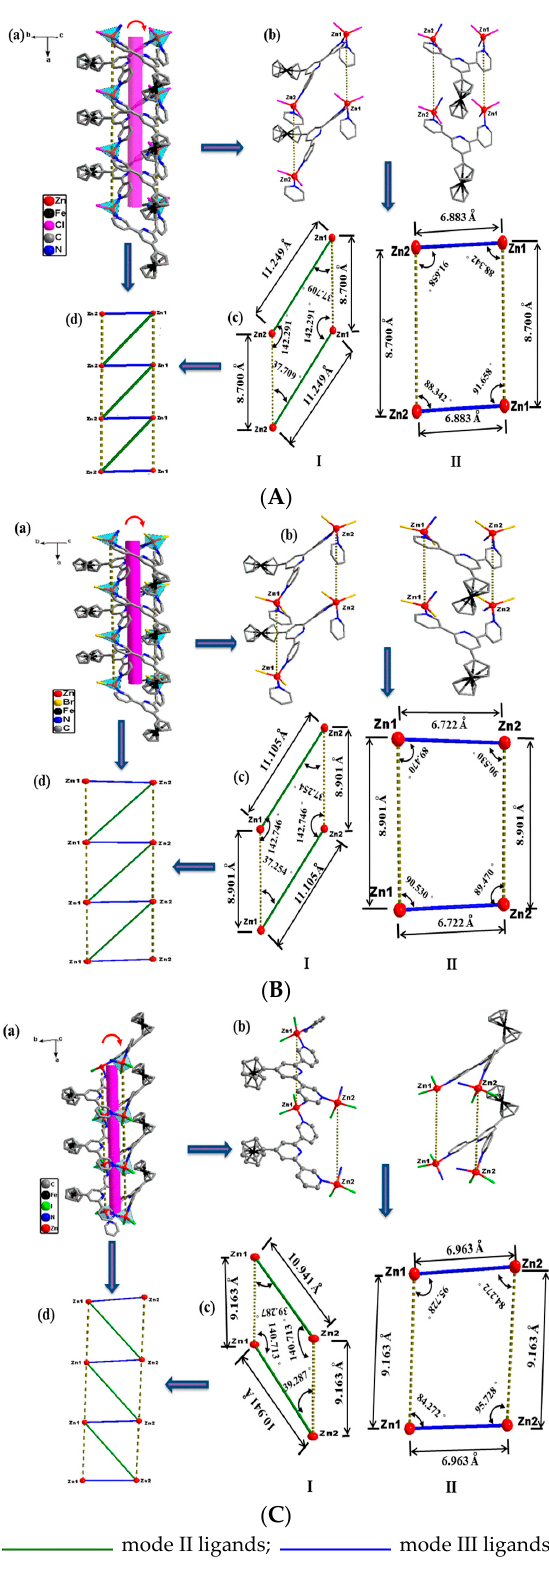
Figure 5. (a) The 1D double-stranded metal ion left-handed helical polymer chains of complexes 1 ( A ), 2 ( B ) and 3 ( C ) (H atoms and solvent molecules are omitted for clarity); (b) two connecting formations connected by different coordination mode ligands; (c) two types of parallelogram-like skeletons; (d) the ladder-like